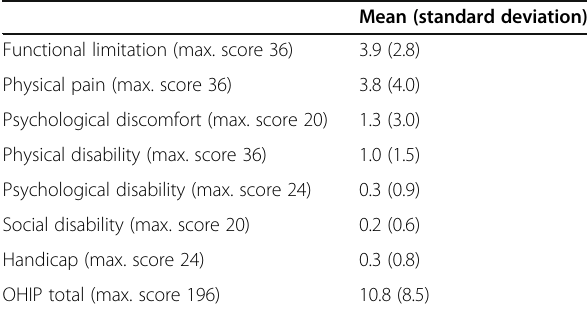
Table 6 Mean sum scores (with standard deviation) of Oral Health Impact Profile questionnaire (OHIP-NL49) at time of follow-up